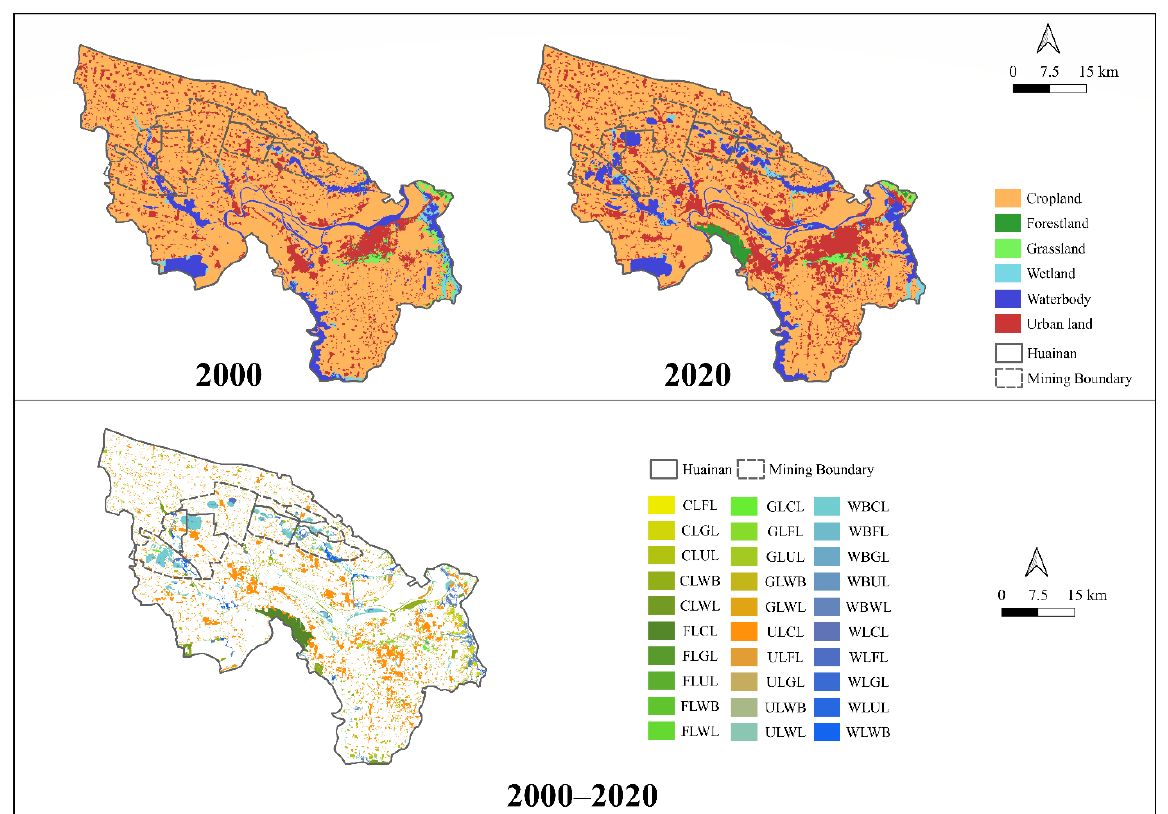
Figure 2 . Schematic diagram of LUCC (where CLFL represents the change in land types from FL to CL, with the rest remaining the same; CL means cropland; FL means forestland, GL means grass- land; WL means wetland; WB means waterbodies; and UL means urban